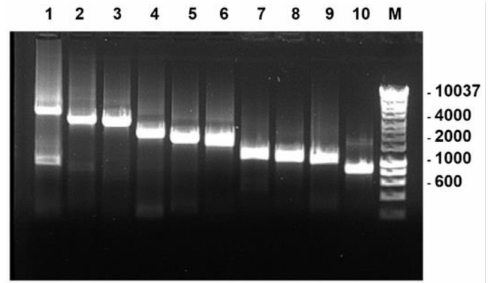
Figure 1. T7 full-length PCR products corresponding to genome segments 1–10 of BTV-1 (lanes 1–10) analysed by 1% agarose gel electrophoresis. These PCR products were used for in vitro transcription with T7 polymerase. Lane M: DNA size marker labelled in base pairs (bp).